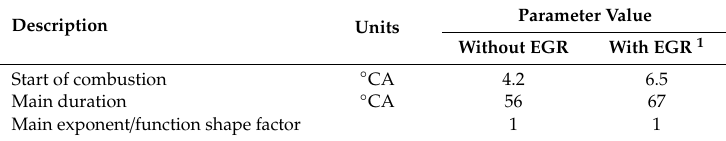
Table 2. Single-Wiebe function parameters (diesel mode 100% load).